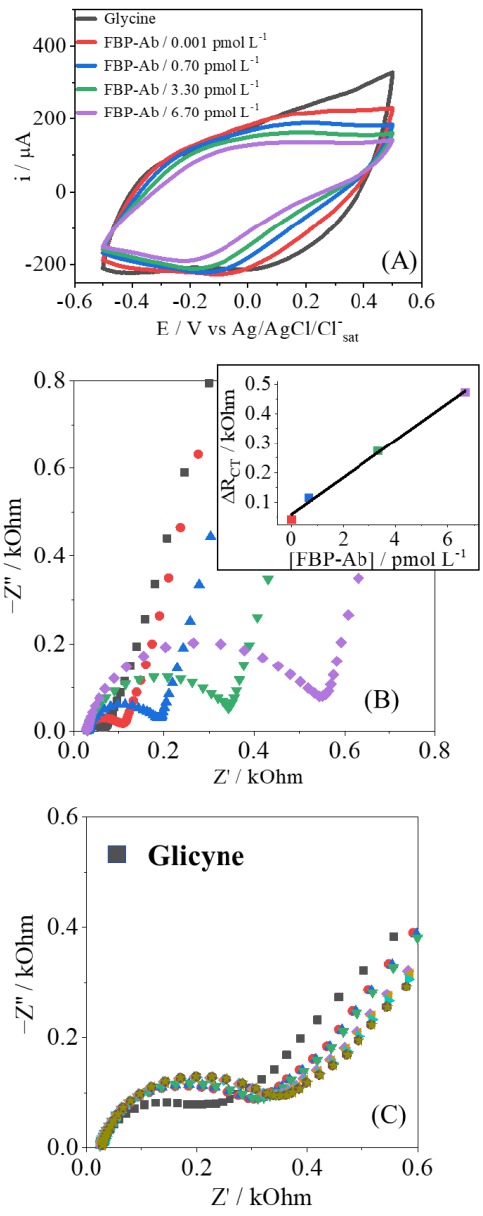
Figure 5. Cyclic voltammetry ( A ) and Nyquist plot ( B ) to FBP-Ab detection (0.001 up to 6.70 pmol L − 1 ); ( C ) the EIS response in stability test to 0.001 pmol L −1 of FBP-Ab. The gray measurement was performed in the blank step, while the others correspond to the same antibody concentration.